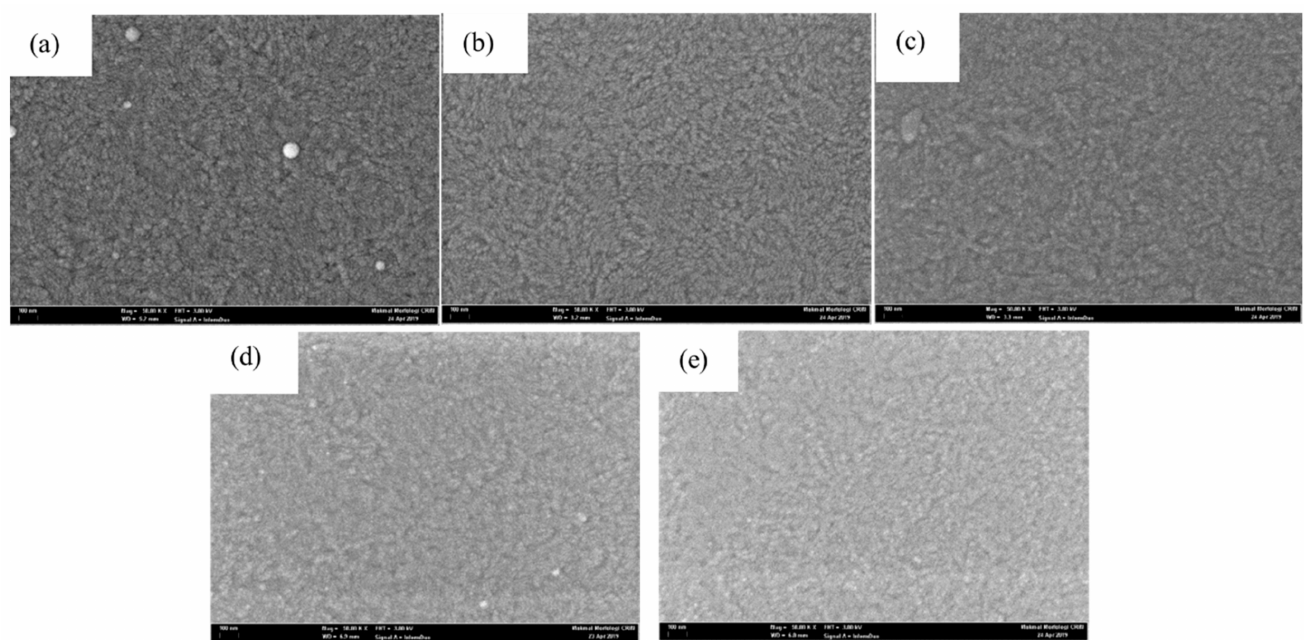
Figure 6. Surface morphology of Cr-doped NiO at different doping times ( a ) Undoped ( b ) 20 s ( c ) 40 s ( d ) 60 s ( e ) 80 s.